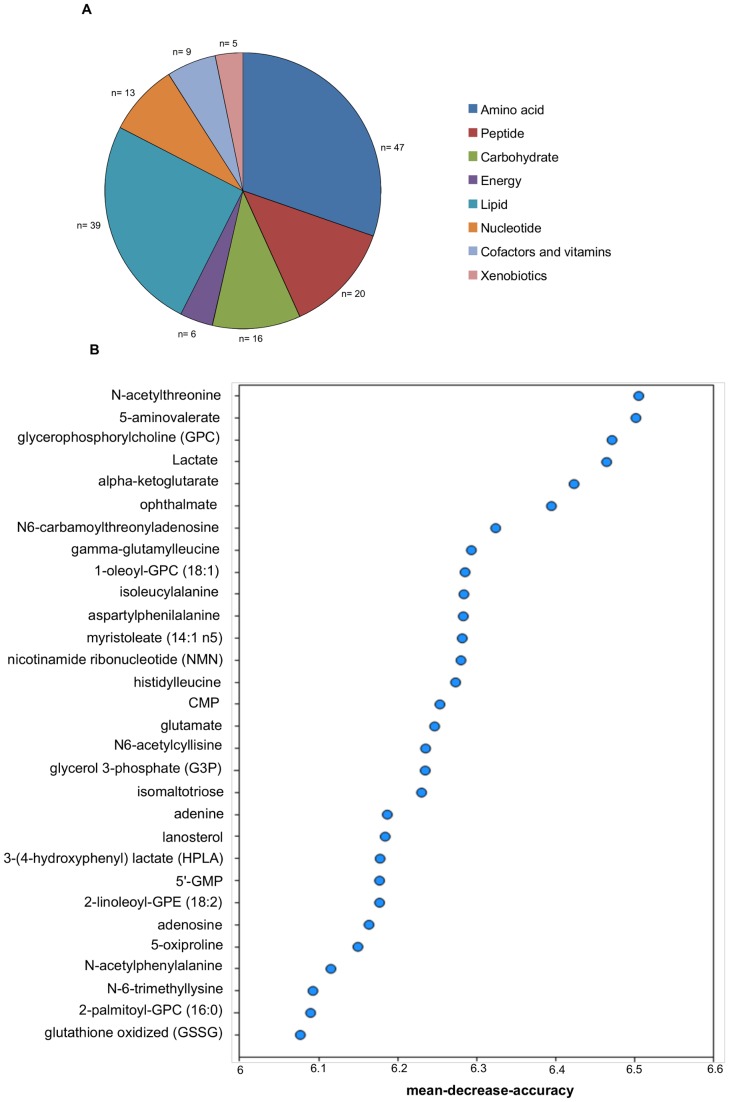
Principal metabolic differences between Sc growing at 12°C and at 28°C.A) Class distribution of the different identified metabolites. n  =  number of metabolites in each class. B) The Random Forest statistical analysis of the metabolomic data was used to identify the top 30 biochemicals with the greatest influence in distinguishing different groups. Metabolites are listed on the y-axis in order of importance, which importance decreasing from top to bottom. The mean decrease in accuracy for each metabolite is plotted on the x-axis.